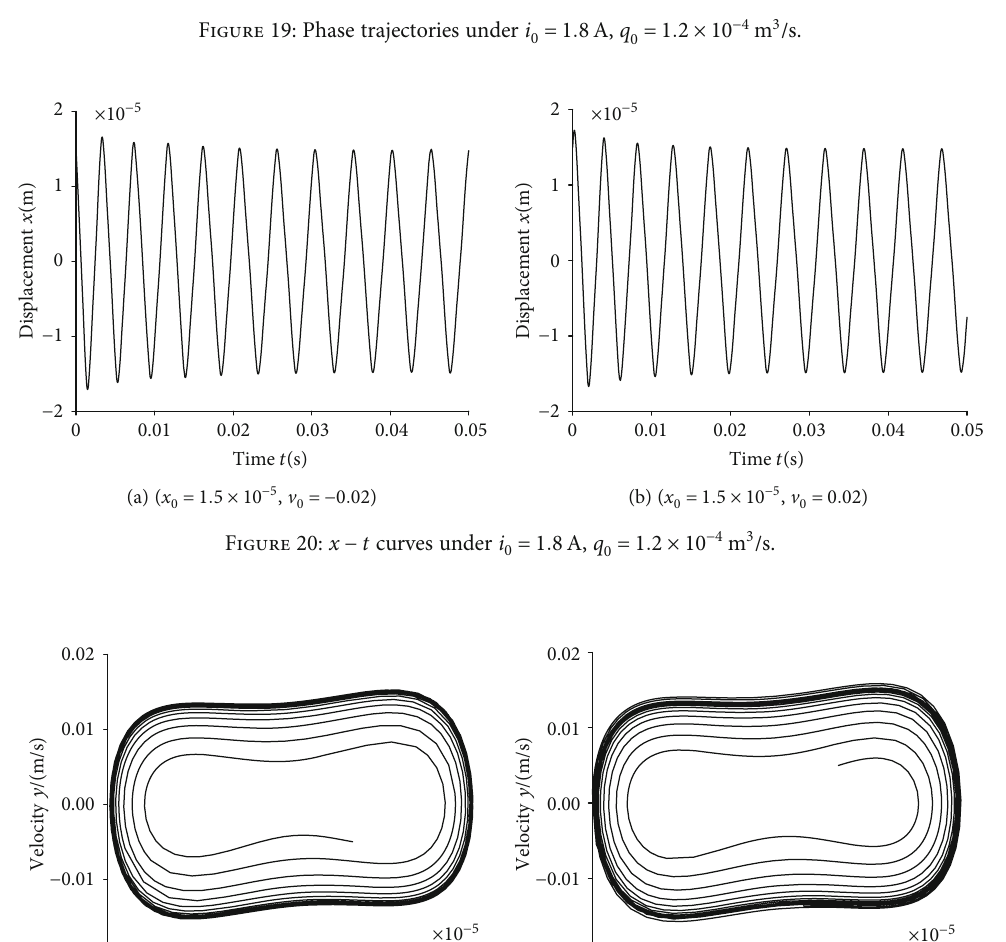
Figure 19: Phase trajectories under i